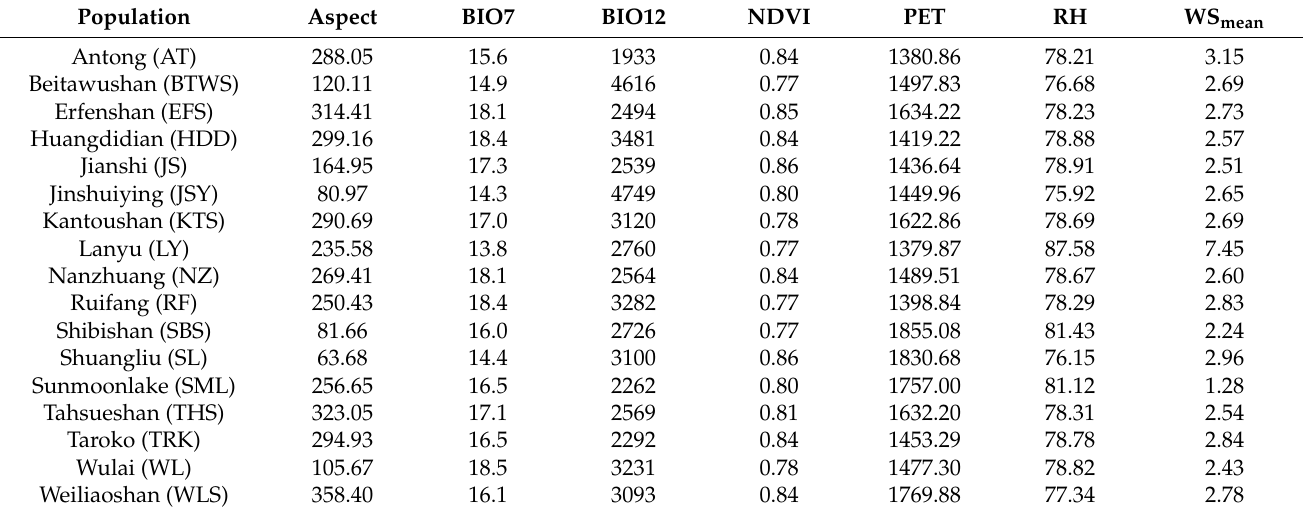
Table 1. The seven retained site environmental variables of the 17 populations of Zingiber kawagoii